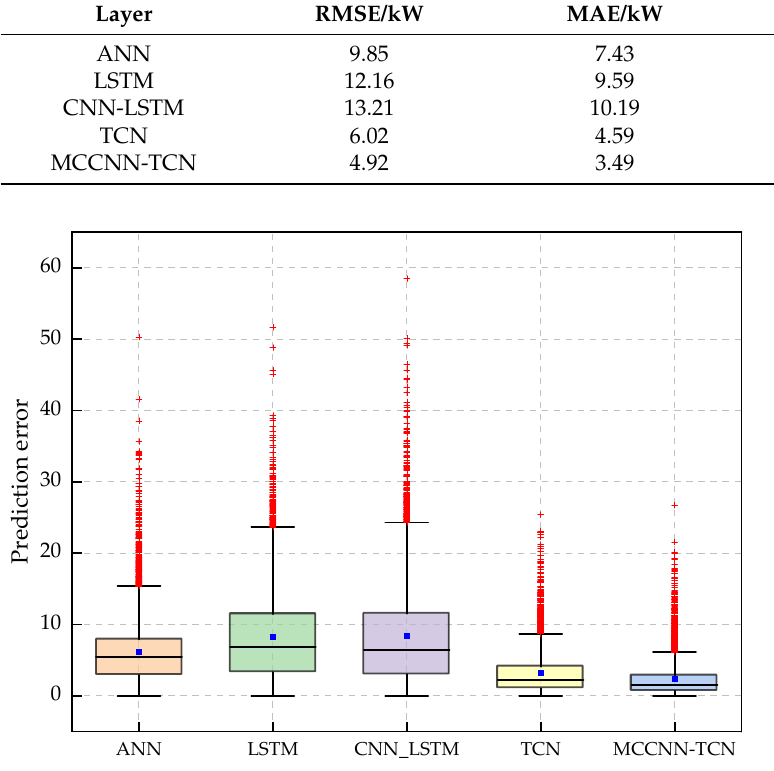
Figure 8. Box plot of absolute prediction errors for different methods.